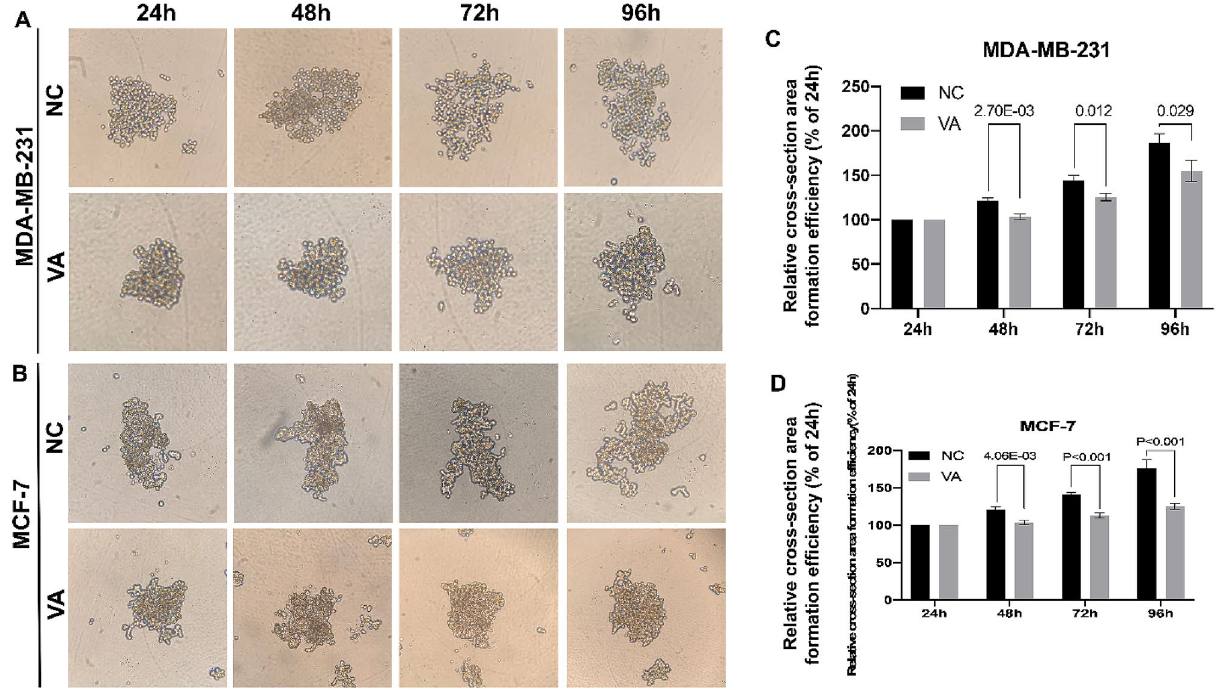
Figure 4. Valeric acid inhibits the 3D formation of MCF-7 and MDA-MB-231 cells. ( A ) illustrated the dynamic changes of 3D formation for MDA-MB-231 cells. ( B ) showed the dynamic changes of 3D formation for MCF-7 cells. Their relative cross-section area formation efficiencies were shown in ( C , D ). Significant reduction of cross-section area of MDA-MB-231 cells ( C ) and MCF-7 cells ( D ) in VA treated groups were observed.